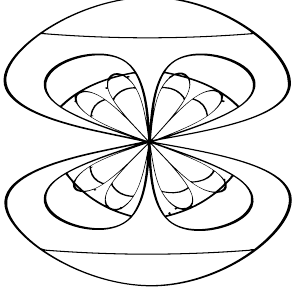
Figure 19. TI read by CC at IML.